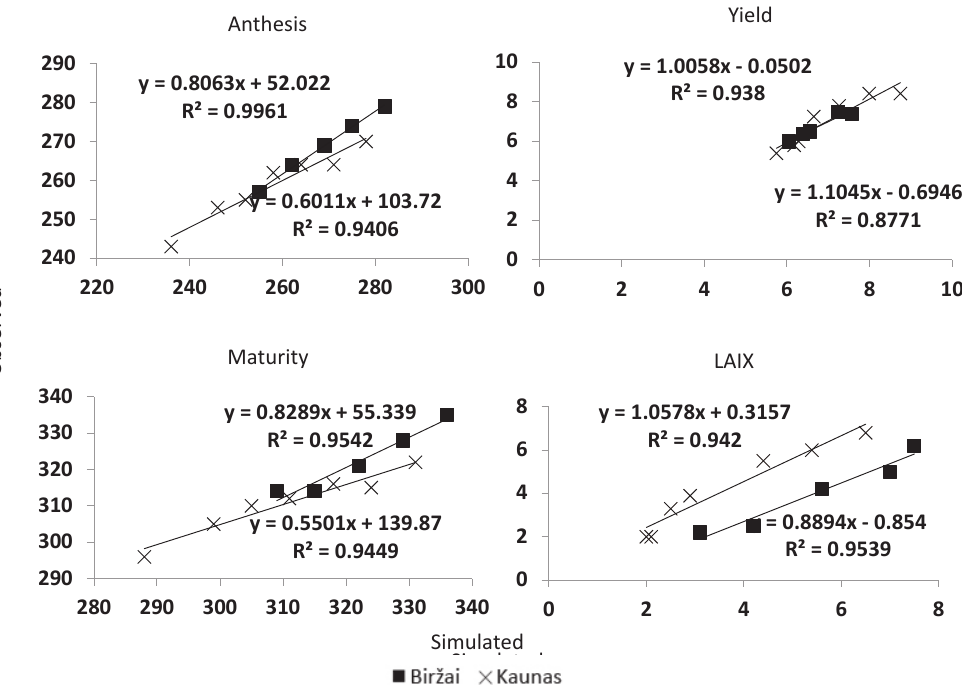
Fig. 2. Calibration curves for winter wheat anthesis, maturity (days after sowing), grain yield (t ha -1 ) and LAIX (maximum leaf area index) plotted as observed vs simulated